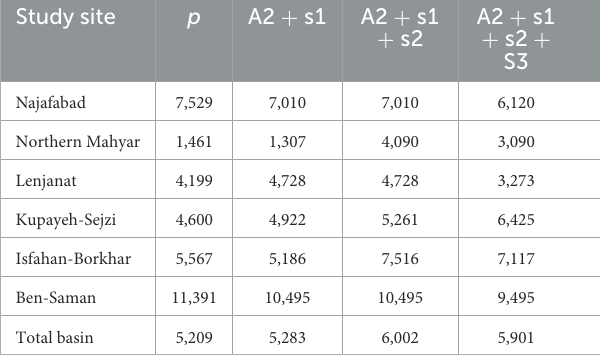
TABLE 7 The results of different scenario on water economic efficiency (IRR/m 3